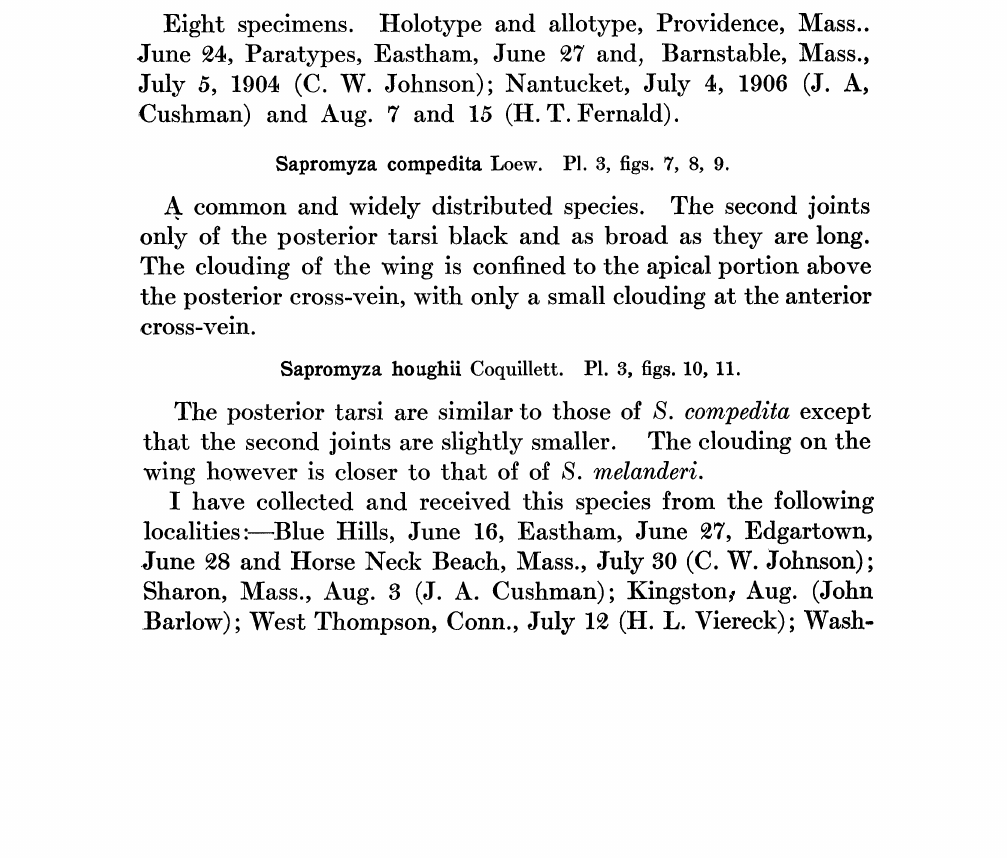
Male: Front and antennm bright yellow, the face and occiput light yellow, arista pubescent, black, base yellow. Thorax dark yellow, with three dorso-centrals, scutellum yellow with four marginal bristles. Abdomen dark yellow, ttalteres and legs light yellow, posterior tarsi whitish, tip of the metatarsus black and broad- ened, the following joint as broad as it is long, black with the basal third- white, the next joint only slightly broadened apically and these joints are each armed with two longer, curved black bristles as in S. ornatipes, but less flattened at the ends. Wings hyaline with the cloudings less distinct than in the preceding species, the costal clouded area being often obsolete beyond both the anterior cross-vein and the end of the second vein, and the band extending to the posterior cross-vein interrupted. Length, 8 mm. The female resembles the male except that the posterior tarsi are simple, the tips of the metatarsi and the outer half of the following joints